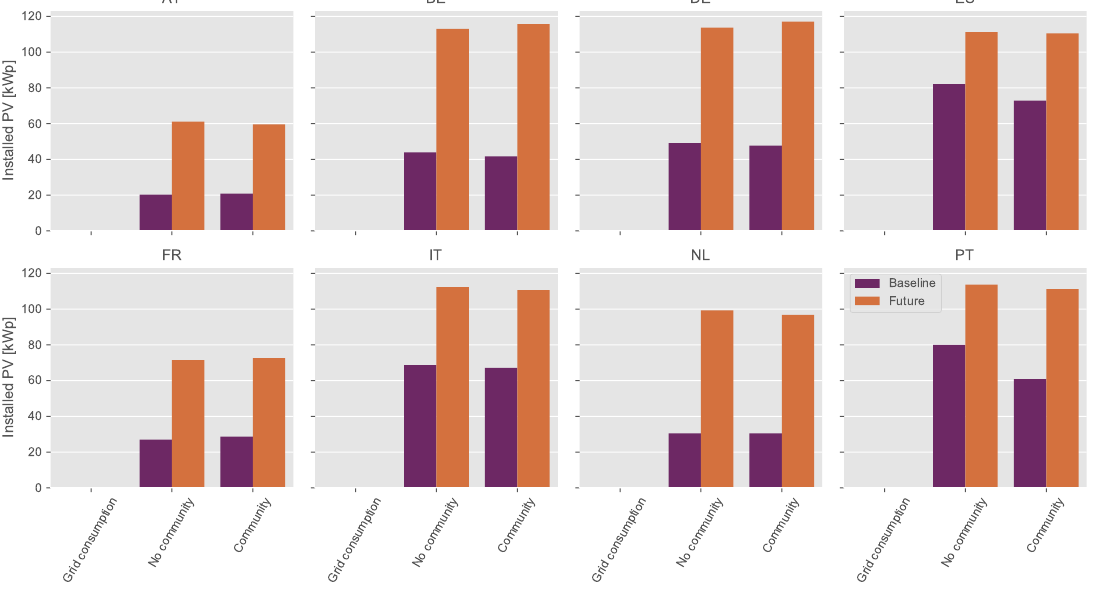
Figure 6. Investments into solar photovoltaic (PV) for all countries.